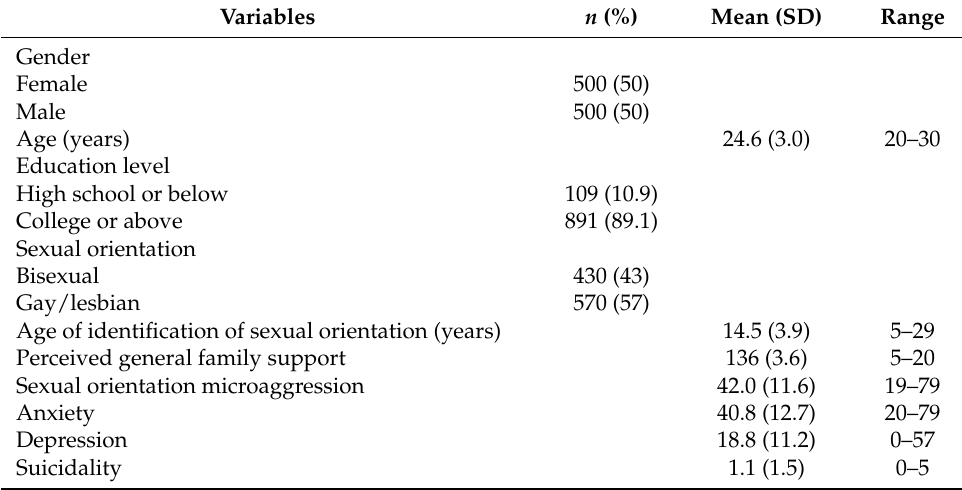
Table 1. Participants’ characteristics (N = 1000).